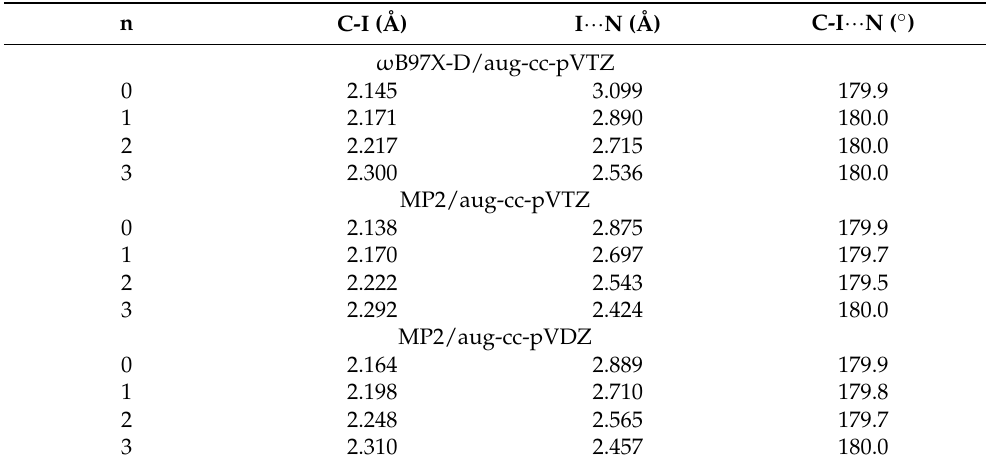
Table 4. Optimized geometries for the CH 3 − n (CN) n I ··· NMe 3 complexes; C-I bond lengths, I ··· N distances and C-I ··· N angles are